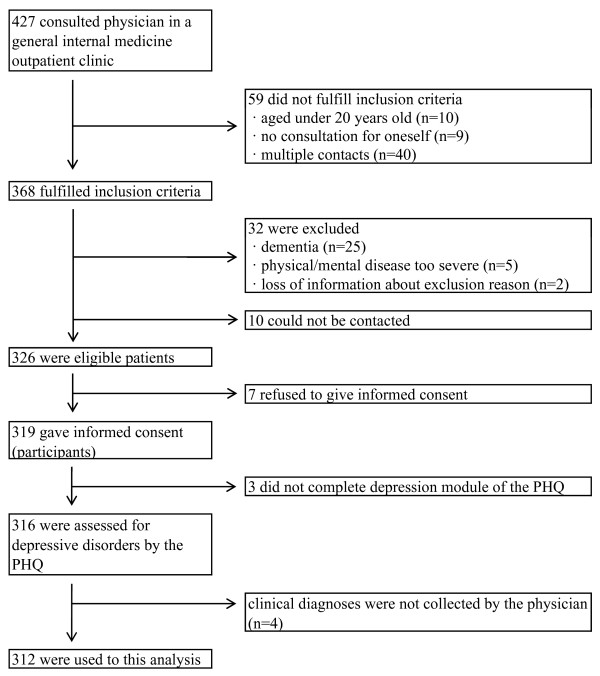
Sampling Process.